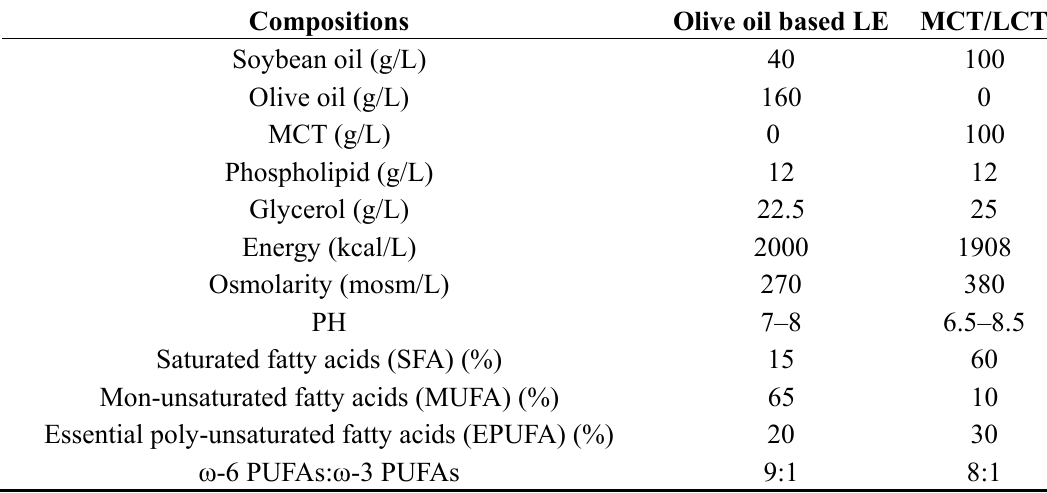
Table 1. The compositions of the two lipid emulsions. Compositions Olive oil based